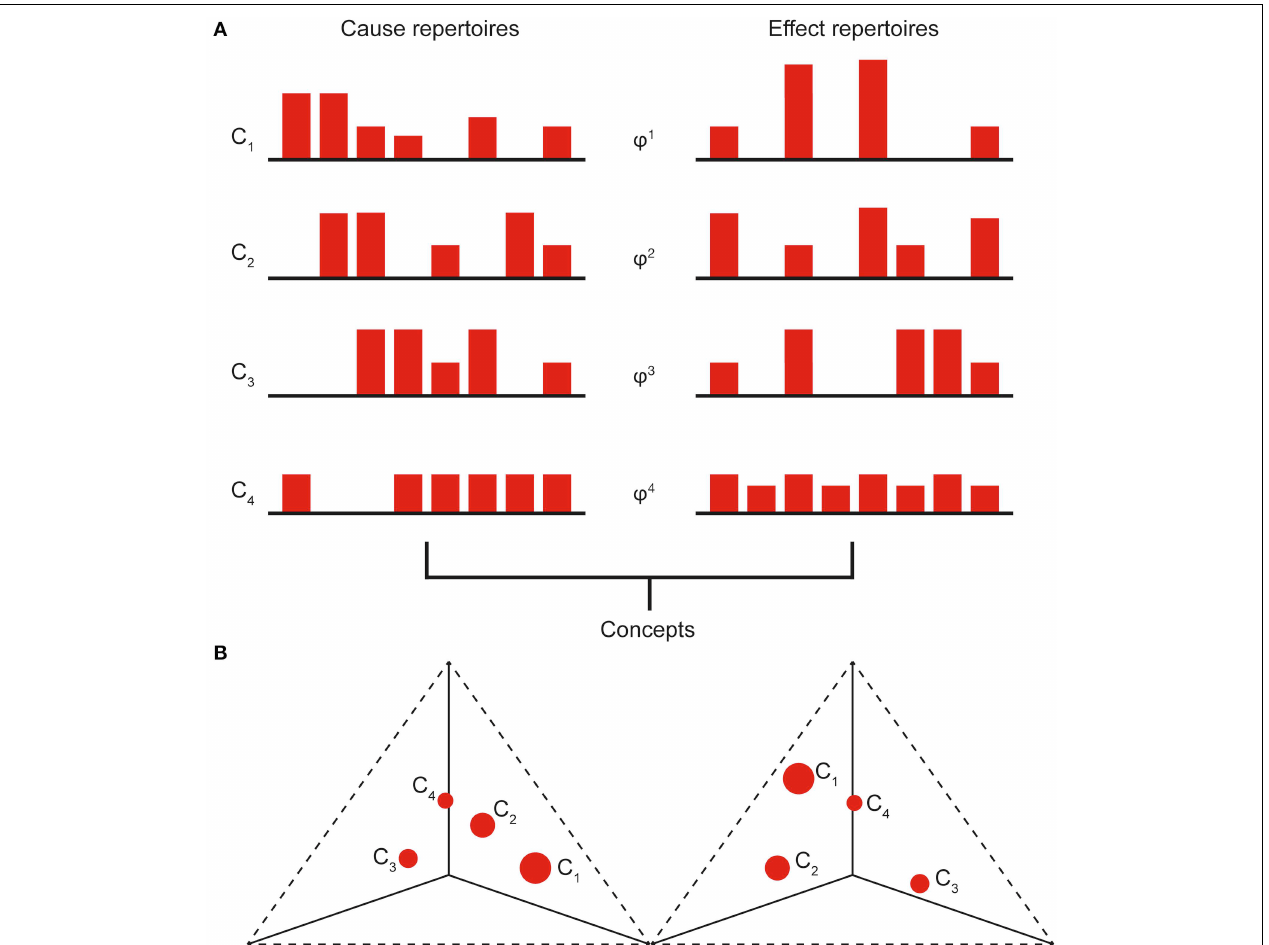
with each cause-effect repertoire state occupying a single axis. Plotting the concepts on these axes, the conceptual structure forms a shape in this space that is identified with the conscious experience (qualia). (Only 3 axes shown with past and future states plotted on